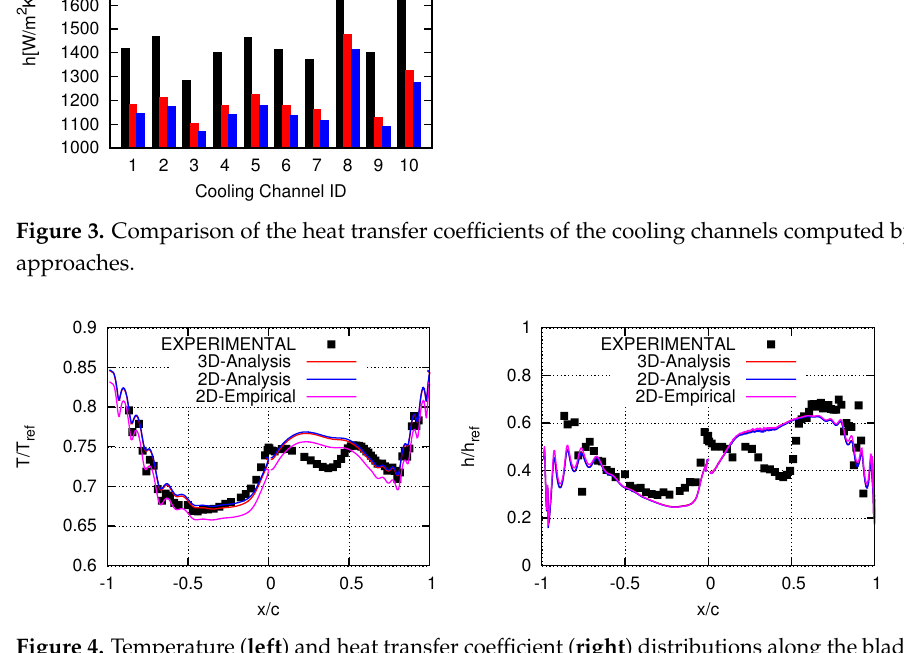
Figure 4. Temperature ( left ) and heat transfer coefficient ( right ) distributions along the blade contour obtained by 3D and 2D CHT runs. The 2D runs use the channels’ heat transfer coefficients computed by the two approaches presented in the